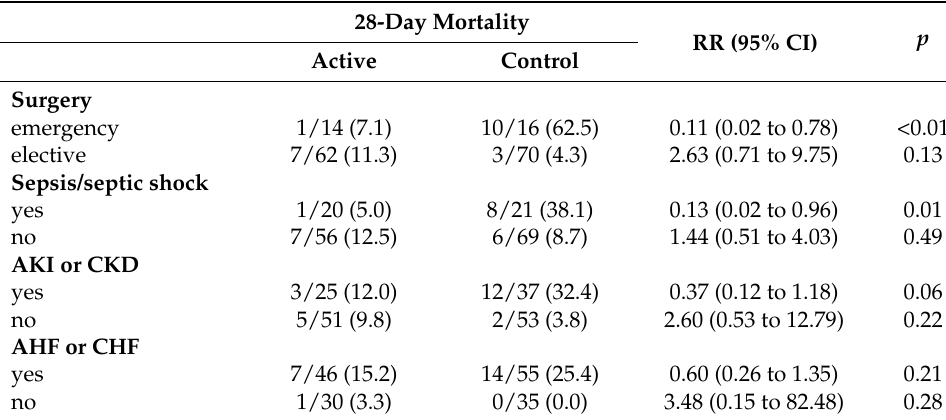
Table 6. Primary outcome across non-prespecified